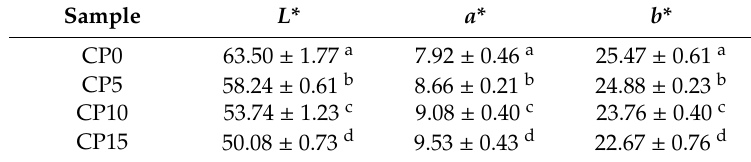
Table 5. Means and standard deviations of the colour measurement parameters across